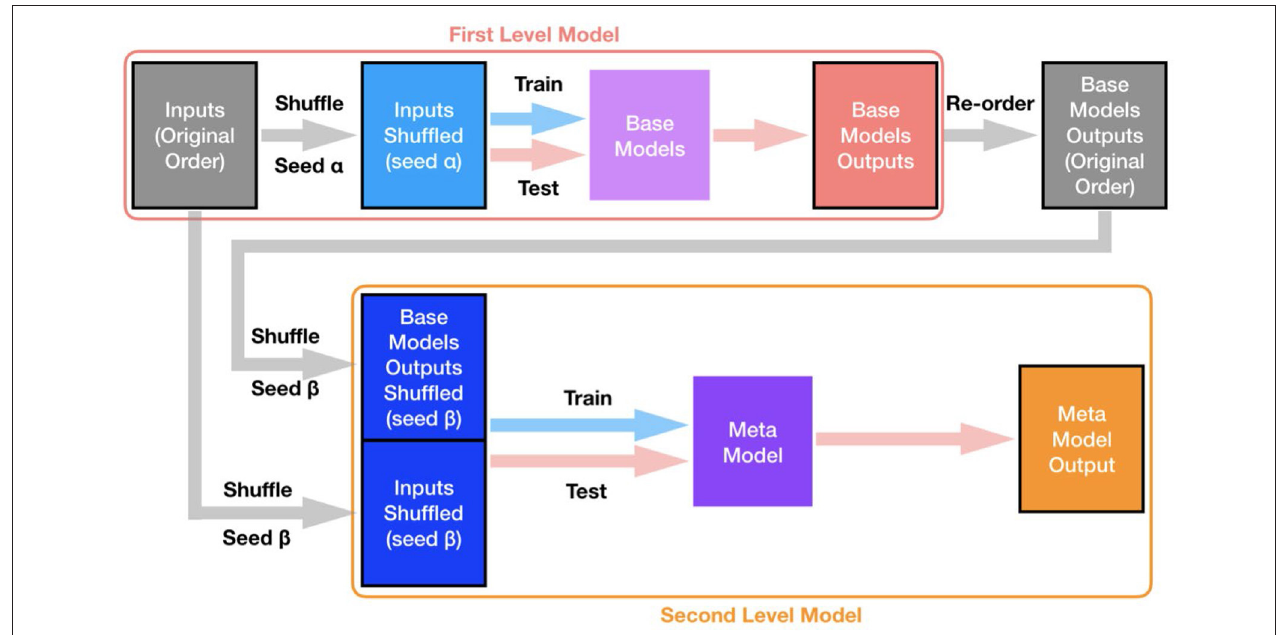
FIGURE 4 | Overall process for training and evaluation of the two-level stacking model. Both base models and the meta model were all trained and evaluated in the cross-validation manner. The shuffling process (to split subjects into different folds for cross-validation) for base models is controlled by a certain random seed α (shared for all base models), while the shuffling process for the meta model is controlled by a different random seed β